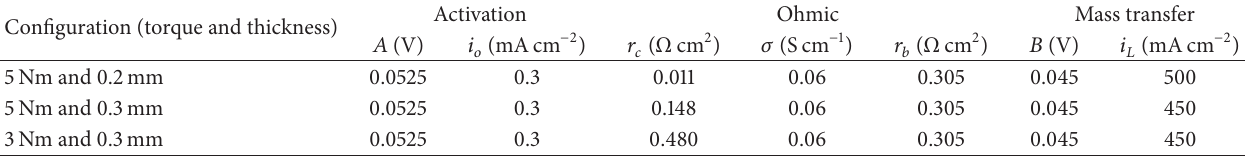
Table 1: Parameters used for the modelling of the polarisation behaviours. Configuration (torque and thickness)